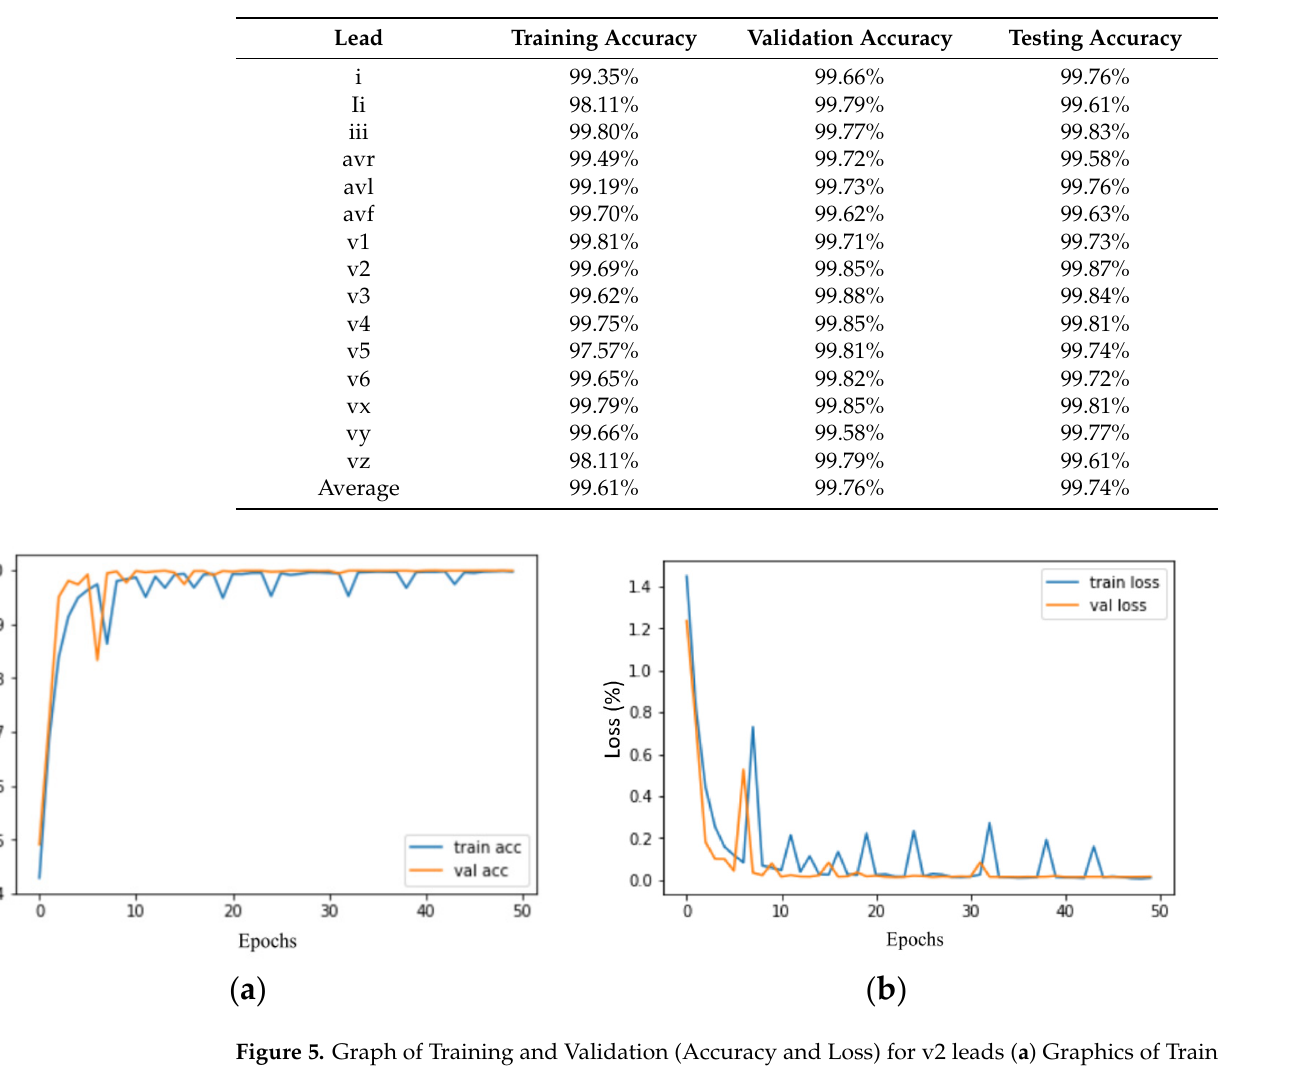
Figure 5. Graph of Training and Validation (Accuracy and Loss) for v2 leads ( a ) Graphics of Train Acc and Val Acc 10 class MI and Normal in lead v2; ( b ) Train Loss and Val Loss graphs for 10 classes MI and Normal classes in lead v2.